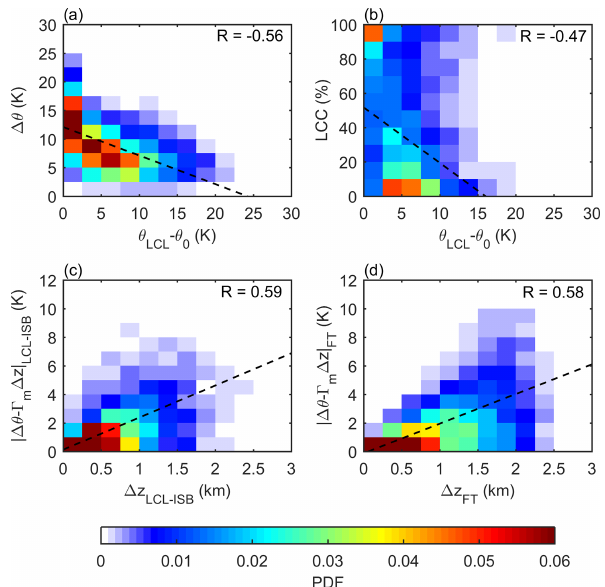
Figure 4. Joint PDFs of the θ difference ( (cid:49)θ ) between the levels of 3km and the LCL (with the IS excluded) and θ LCL − θ 0 (a) , and PDFs of LCC and θ LCL − θ 0 (b) . Joint PDFs of the absolute value of the θ difference with the moist adiabat removed ( (cid:49)θ − (cid:48) m (cid:49)z ) and the height difference ( (cid:49)z ) from the LCL to the inversion base (c) and from the inversion top to 3km in the free troposphere (d) . Correlation coefficients ( R ) are listed in the upper-right corner of each panel. The dashed black lines indicate the least-squares